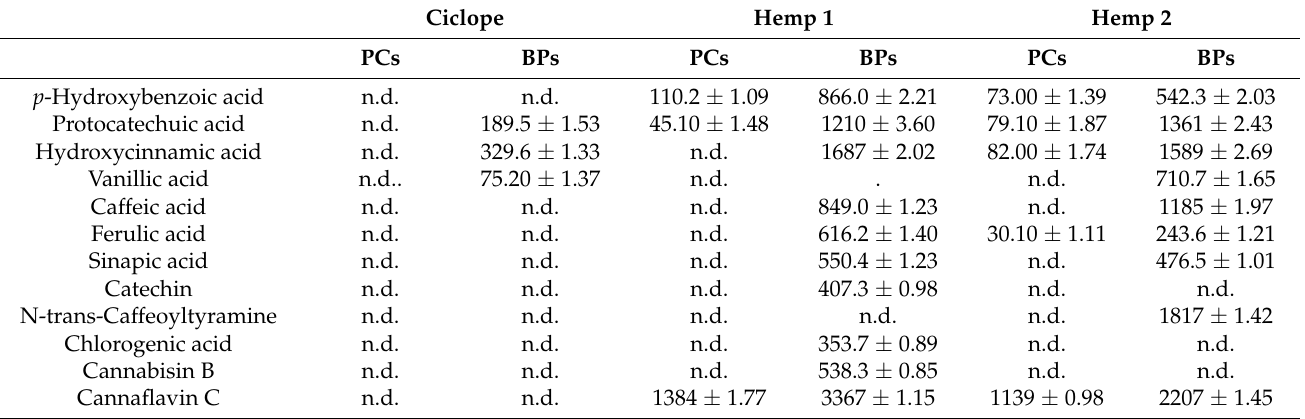
Table 5. Phenolic compounds ( µ g 100 g − 1 ): Free and bound quantification (PCs and BPs) of raw